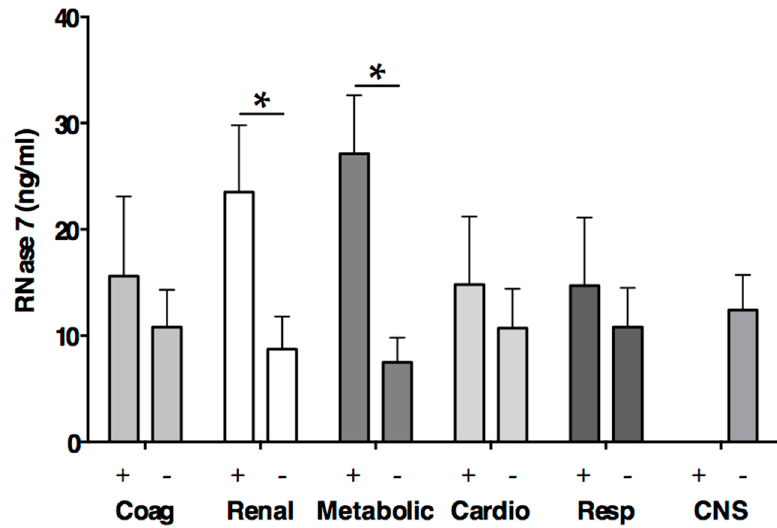
Figure 5. RNase 7 levels according to organ dysfunctions defined by the Surviving Sepsis Campaign [40]. * p < 0.05; Coag Coagulation; Cardio Cardiovascular; Resp Respiratory; CNS Central nervous system; Plus (+) denotes presence of organ dysfunction; Minus ( − ) denotes absence of organ dysfunction.